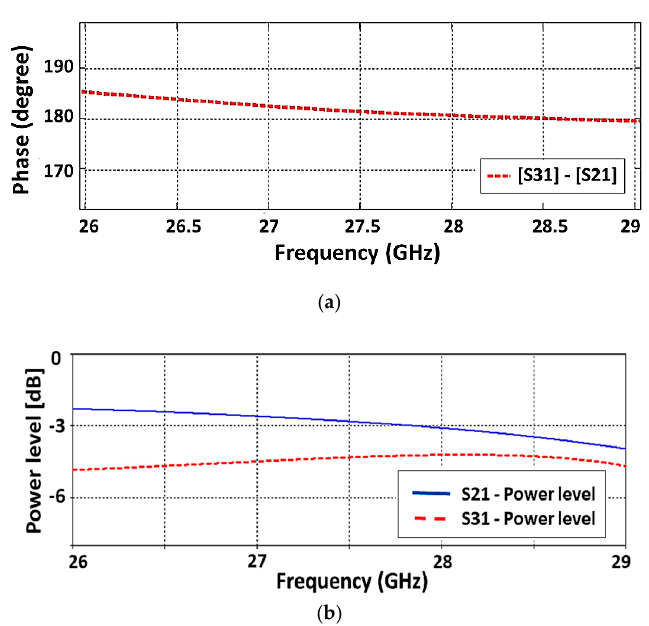
Figure 5. ( a ) Output port phase difference, and ( b ) power level of two-way H-plane SIW power divider with 180-degree phase difference.